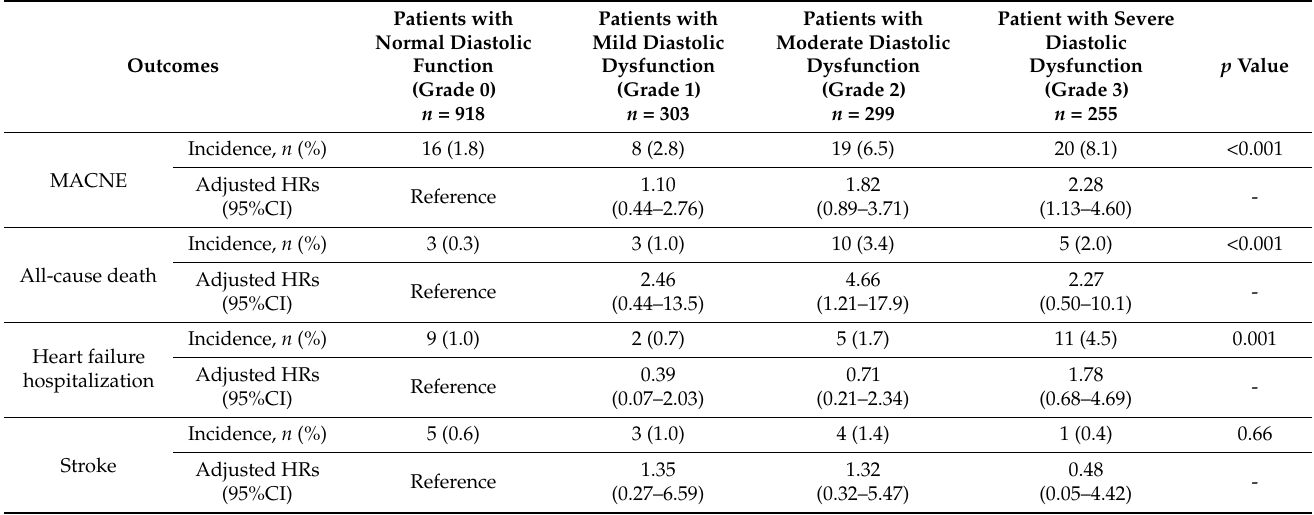
Figure 2. Kaplan–Meier curves for cumulative incidence of major adverse cardiovascular or neuro- logical events during 2-year follow-up. Table 2. Clinical outcomes across patients with diastolic